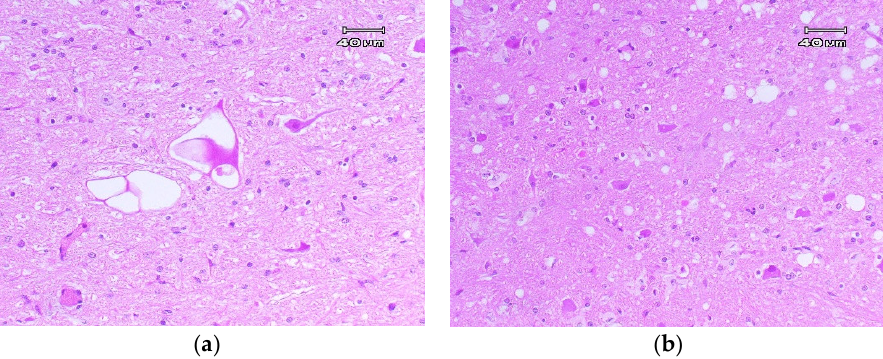
Figure 1 . ( a ) Vacuolization of the neuronal perikaryon. Reticular formation. 20×. ( b ) Spongiform degeneration: Vacuolization neuropil grey matter (spongiosis) located in the thalamus. 20×. Atypical